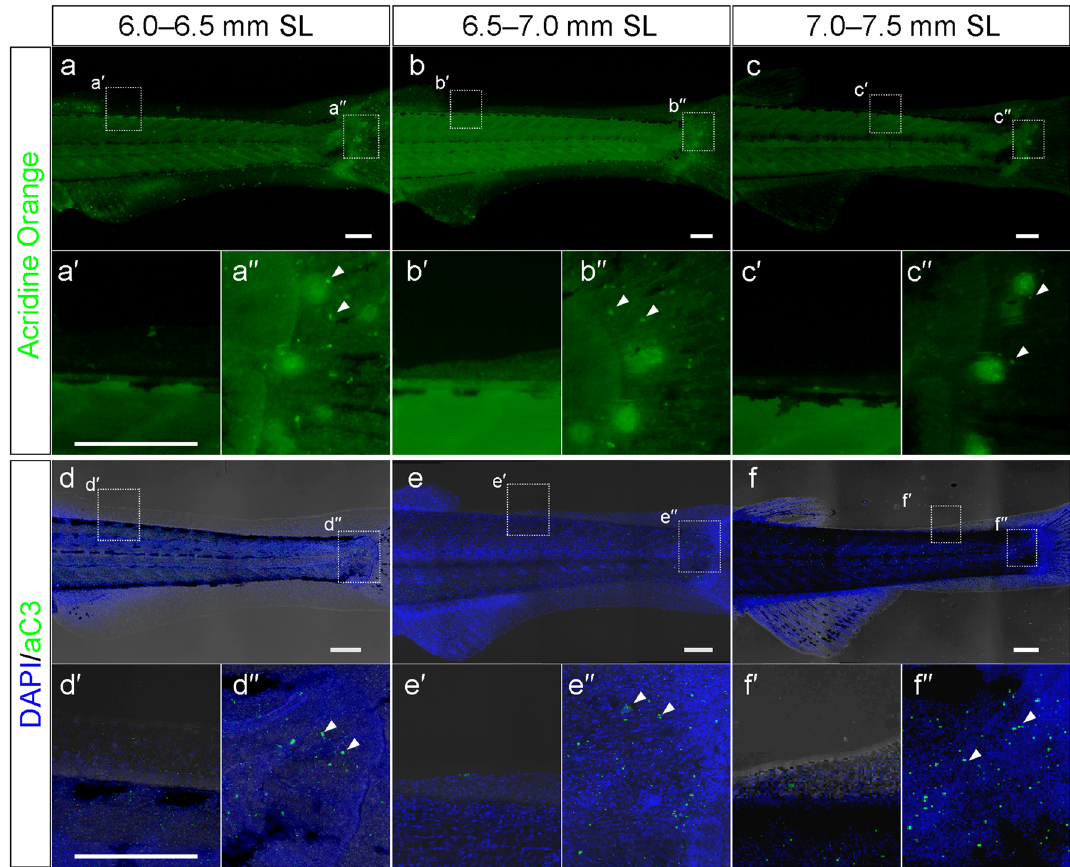
Figure 2. Apoptotic cell death in the reducing LMFF area. ( a – c’’ ) Acridine orange staining in the reducing LMFF area ( a’ , b’ , c’ ) and proximal part of the developing caudal fin region ( a” , b” , c” ) at 6.0–6.5 mm SL ( a – a” ), 6.5–7.0 mm SL ( b – b” ), and 7.0–7.5 mm SL ( c – c” ). The lower panels ( a’ , a” , b’ , b” , c’ , c” ) are magnified views of the dashed rectangles in the upper panels ( a , b , c ), respectively. ( d – f” ) Expression pattern of active caspase 3 in the reducing LMFF area ( d’ , e’ , f’ ) and proximal part of the developing caudal fin region ( d” , e” , f” ) area at 6.0–6.5 mm SL ( d – d” ), 6.5–7.0 mm SL ( e – e” ), and 7.0–7.5 mm SL ( f – f” ). The lower panels ( d’ , d” , e’ , e” , f’ , f” ) are magnified views of the dashed rectangles in the upper panels ( d , e , f ), respectively. Arrowheads in ( a” , b” , c” , d” , e” , f” ) indicate examples of apoptotic cell death signals. Scale bars indicate 200